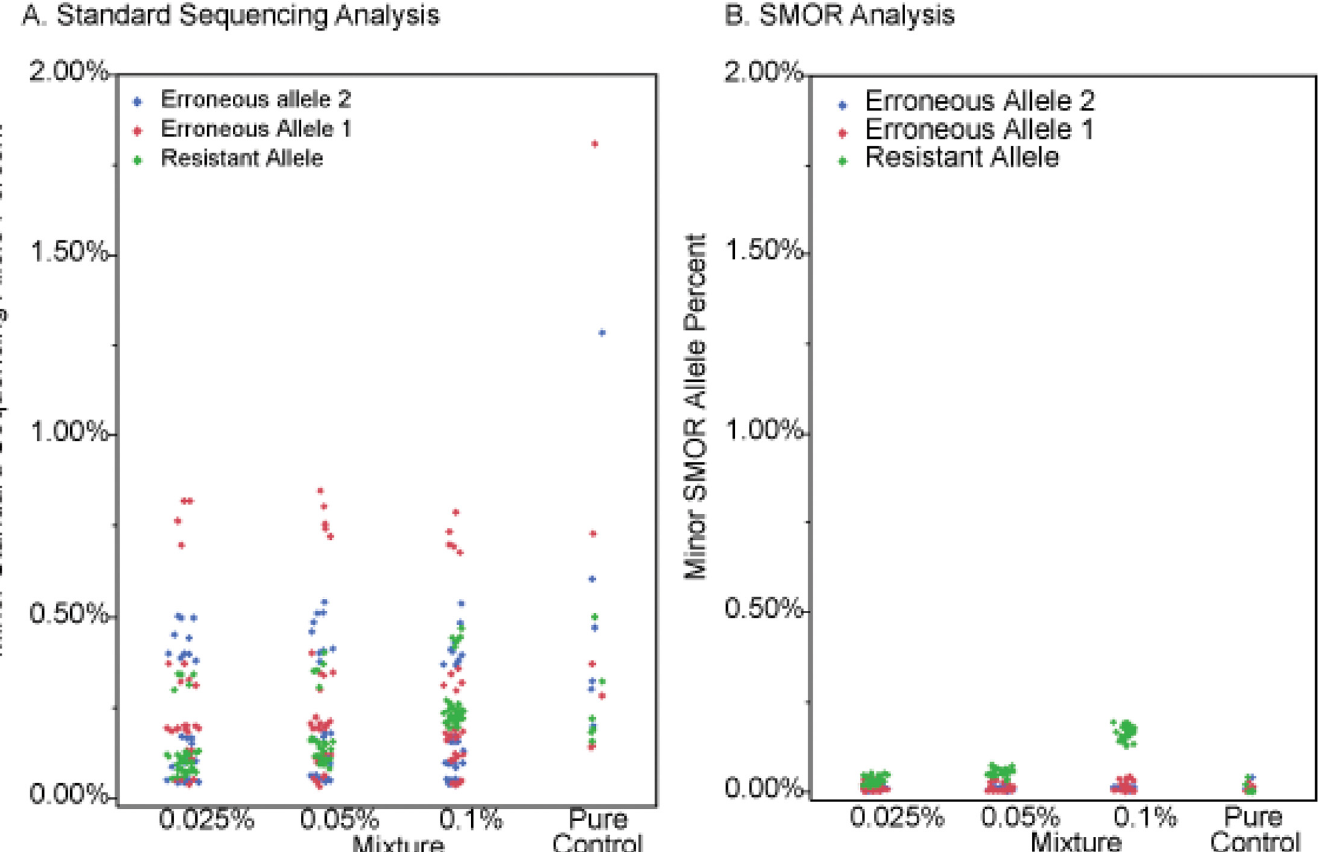
Fig 2. Comparison of standard sequencing and SMOR analysis. The percentage of base calls for the resistant allele compared to the erroneous alleles at six resistant SNP loci in five different genes, five replicates each, is shown. All 36 SNP loci were examined; however most SNP loci are consistent between the resistant and susceptible strains used in the mixtures. The seven different mixtures contain six known allelic differences in resistant conferring loci. Each circle represents the percent of calls for a particular allele for each replicate and the color represents the type of allele. The pure control was the pan susceptible isolate DNA 2 – 0112. A. Results from standard sequencing analysis, ignoring read pair information. B. Results from SMOR analysis. For the means and standard deviations see S6